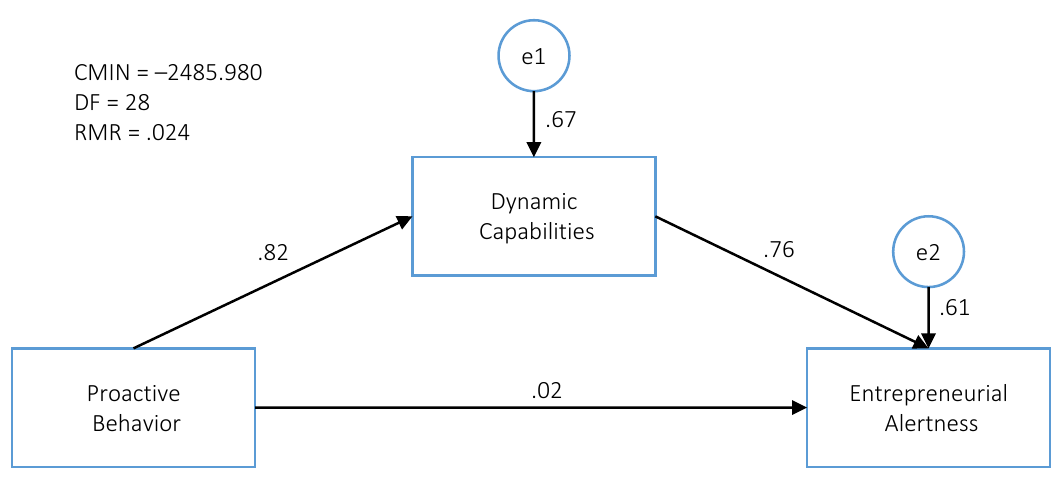
Figure 2. Structural model